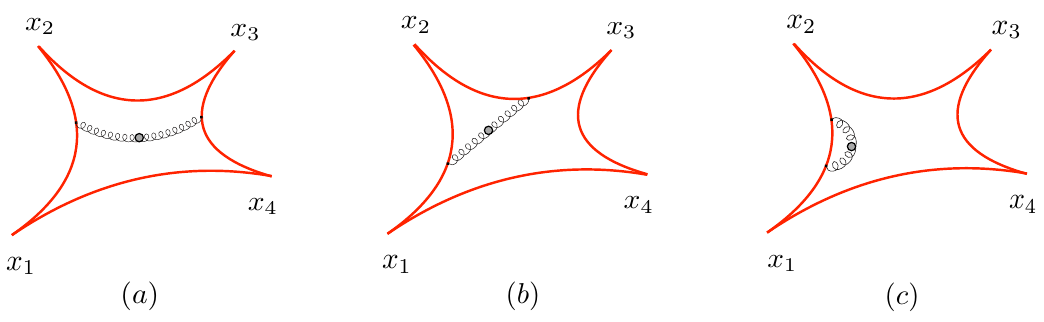
Figure 2 . One-loop graphs for the integrand of the off-shell four-site Wilson loop. The grey blob stands for the Lagrangian insertion